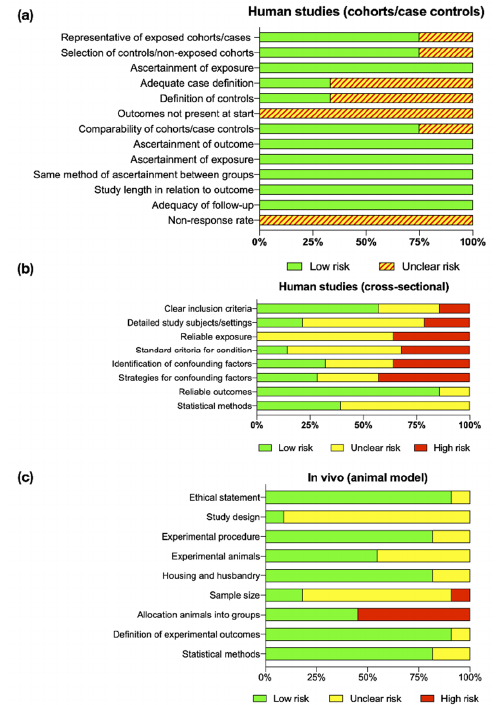
Figure2. Assessmentofqualityandriskofbiasoftheincludedhumannonrandomizedcohorts / case–control Figure 2. Assessment of quality and risk of bias of the included human nonrandomized cohorts/case– ( a ), human cross-sectional ( b ), and in vivo (animal) ( c ) control ( a ), human cross-sectional ( b ), and in vivo (animal) ( c ) studies.